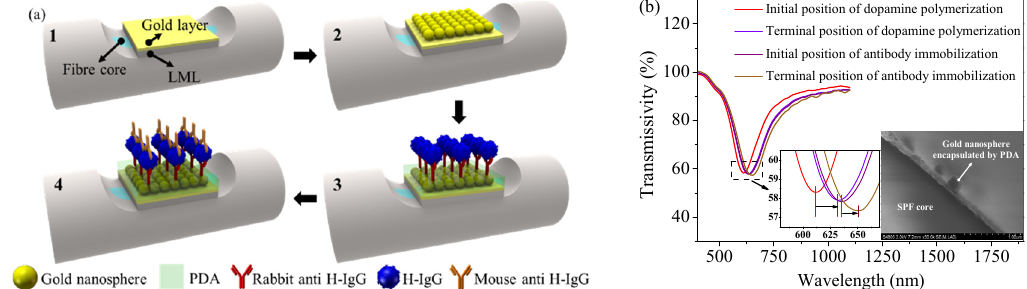
Figure 4. ( a ) Sensing probe manufacturing process. ( b ) Resonance spectrum changes of the sensor after PDA self-polymerization and antibody immobilization. Inset: SEM image of the cross − section of the LR − SPR sensor modified with gold nanospheres and PDA.